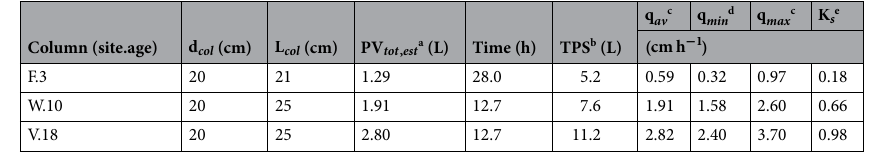
Table 2. Soil column properties, water fluxes q [average (av), minimum (min) and maximum (max)] and total percolated water (L) during the column experiment in the three soil columns F3, W.10 and V.18. a PV tot , est : estimated total pore volume: estimated from pedotransfer functions according to 50 and corrected by stone content (see Eq. 1). b TPS: total percolated biocide/tracer solution (L) after the percolation of four pore volumes. c q av is the average water flux through the soil column and is the slope of the linear regression of the outflow (L) over time (h). d q min and q max are the lowest and the highest calculated water flux during the column experiment. e Calculated according to Eq. (2) with q av and a hydraulic head gradient of 3.2cm cm − 1 (F.3) and 2.9cm cm (W.10 and V.18).